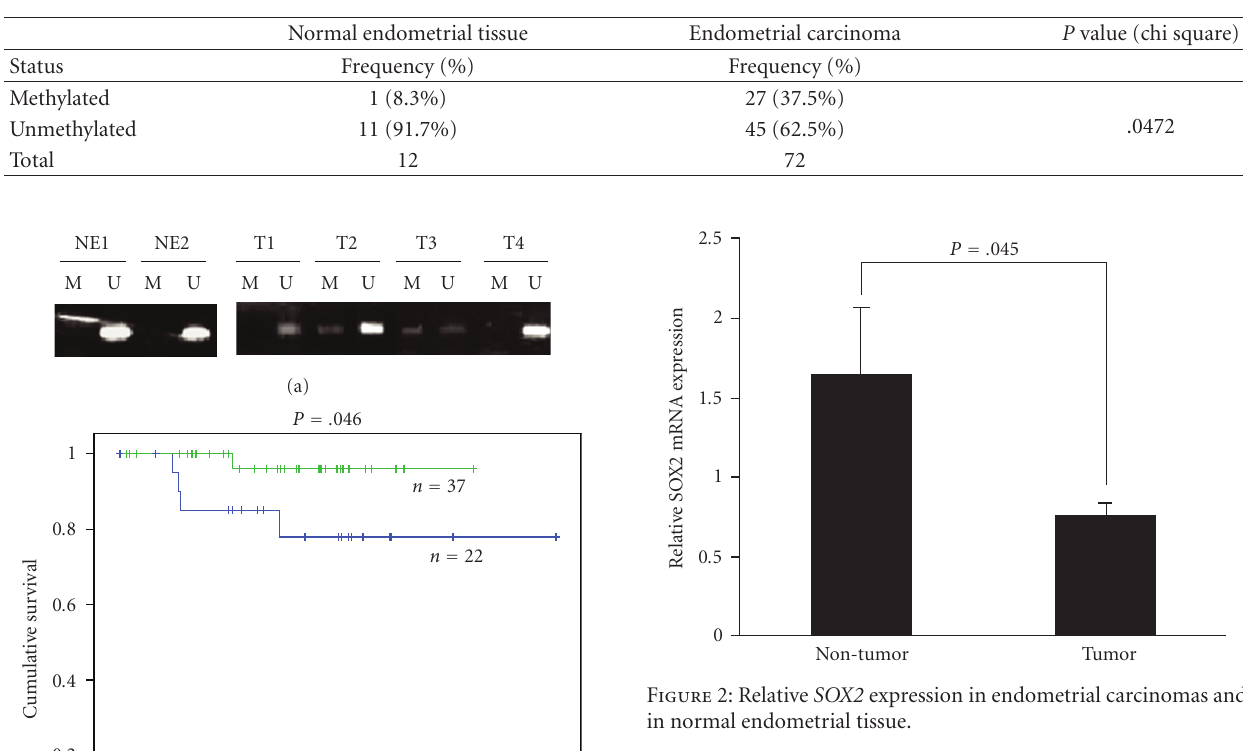
Table 3: Correlation of methylation status of the SOX2 gene in endometrial carcinomas and normal endometrial tissues.